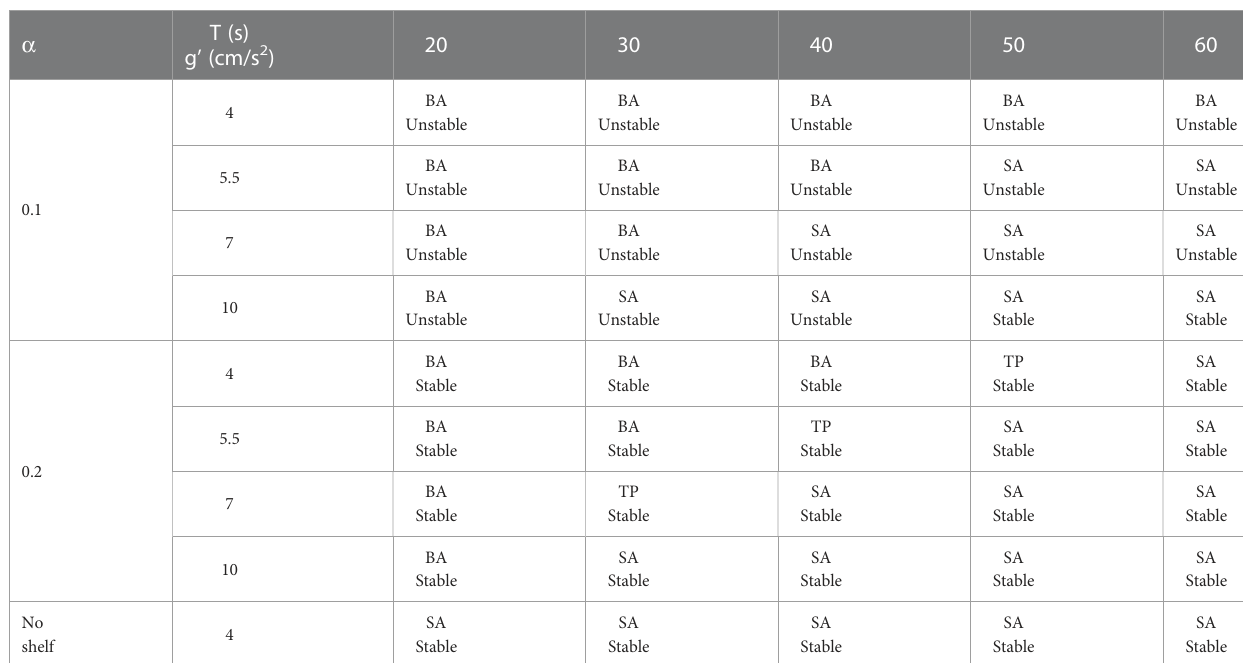
TABLE 2 The plume types of experimental